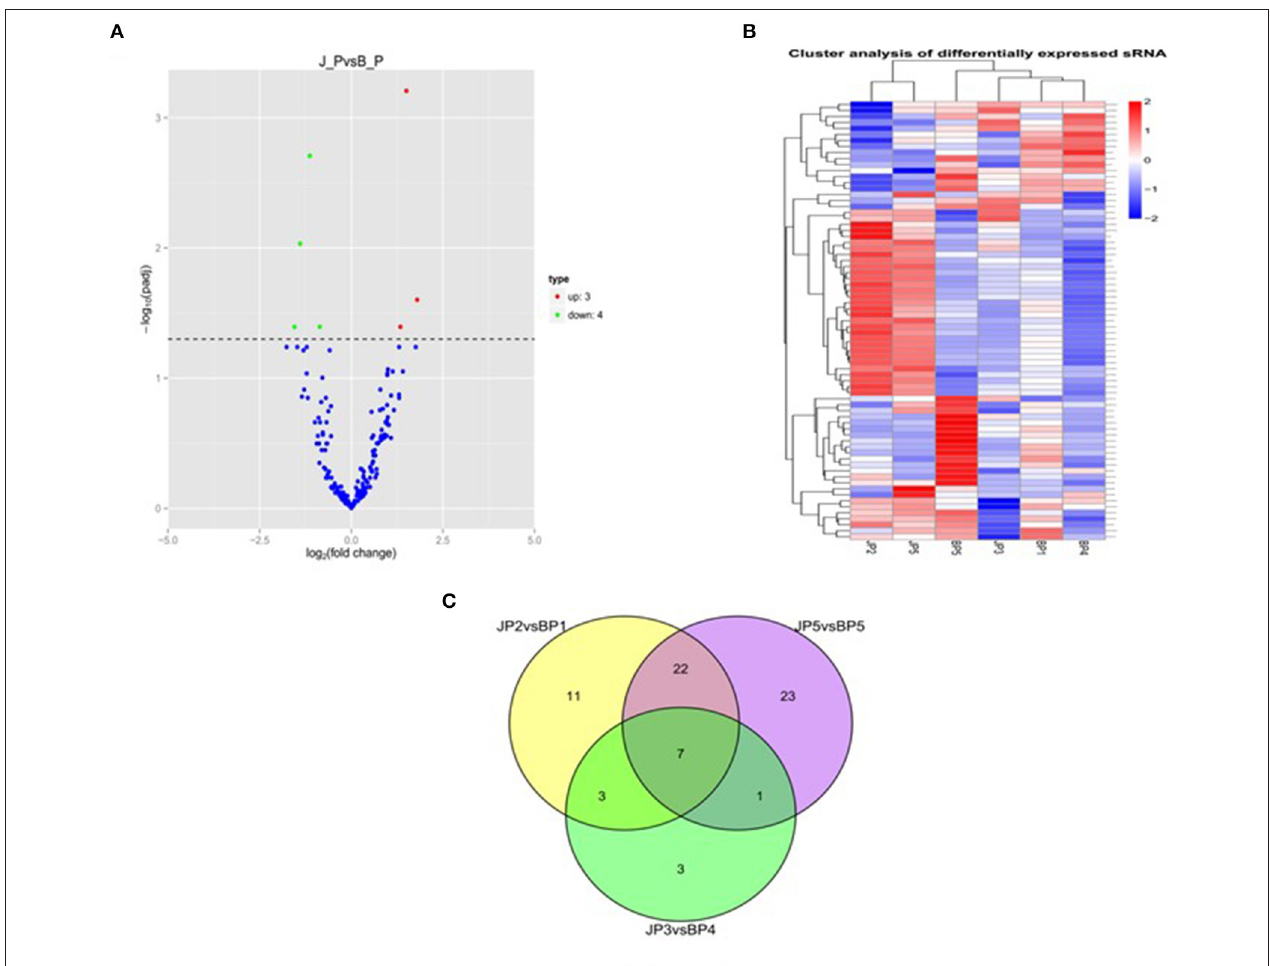
FIGURE 1 | miRNA expression and differential analysis. (A) The difference in expression levels of miRNA between infected and uninfected chicken. The abscissa represents the fold change of miRNA expression in different experimental groups/different samples, and the ordinate represented the statistically significant degree of change in miRNA expression; scattered dots represent individual miRNAs: blue dots represent miRNAs with no significant difference, red dots indicate significantly upregulated differential miRNAs, and green dots indicate significantly downregulated differential miRNAs. (B) Heat map of differentially expressed miRNAs in each paired group (infected vs. uninfected). Red indicates high expression miRNA, blue indicates low expression miRNA. (C) Venn diagram of differential miRNA in six comparison groups. The large circles represent each comparison combination, the sum of the numbers in each large circle represent the total number of differential miRNAs of the comparison combination, and the overlapping parts of the circles represent the number of differential miRNAs in common between the combinations. BP represents the spleen tissue of blank control group; JP represents the spleen tissue of ALV-J-infected